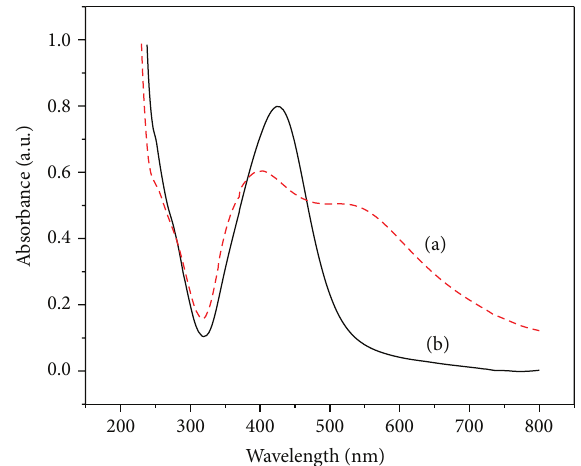
Figure 3: The UV-Vis spectrum of prepared Ag nanoparticles in absence of PAA (only: AgNO 3 -AA-citrate-NaBH 4 ) (a) and in presence of PAA (PAA-AgNO 3 -AA-citrate-NaBH 4 )